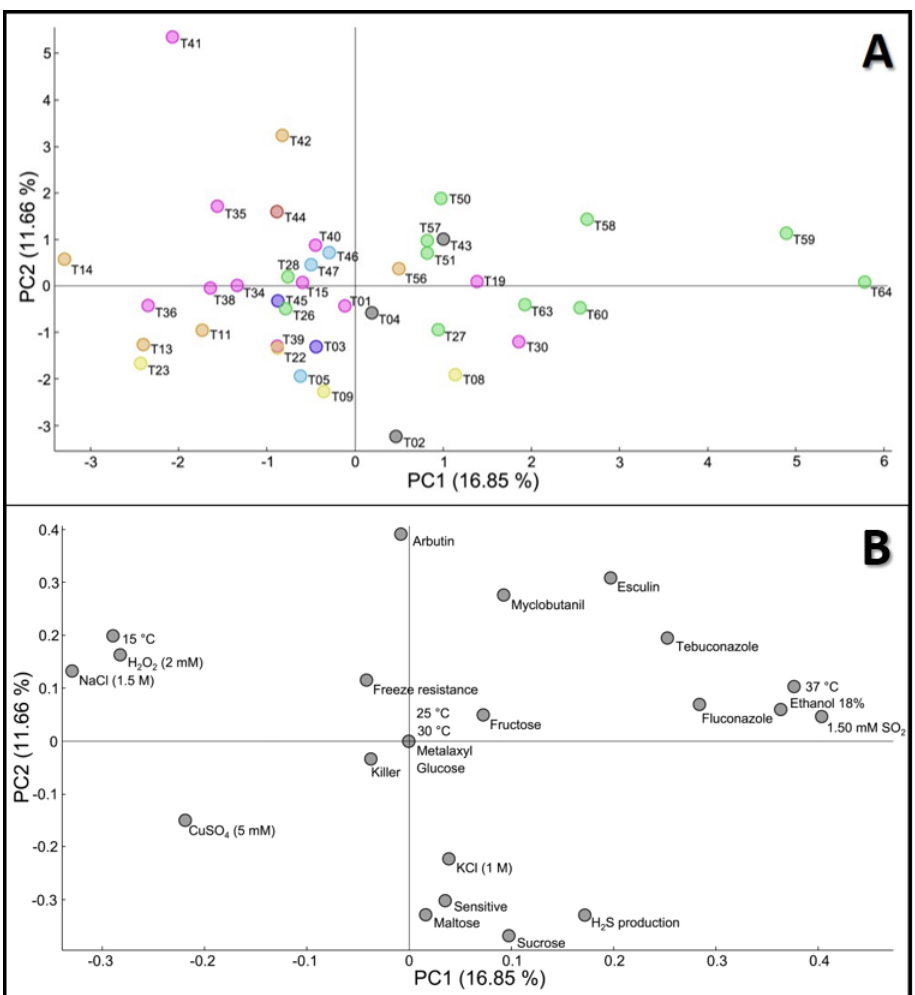
Figure 1. Principal component analysis of phenotypic data of 40 T. delbrueckii strains. ( A ) Scores— 40 strains distribution. Colors represent the technological application or origin of the strains: ● — winemaking; ● —arboreal/soil; ● —food; ● —bread; ● —water; ● —clinical; ● —other beverages; ● — unknown origin; ( B ) Loadings—24 phenotypic tests.